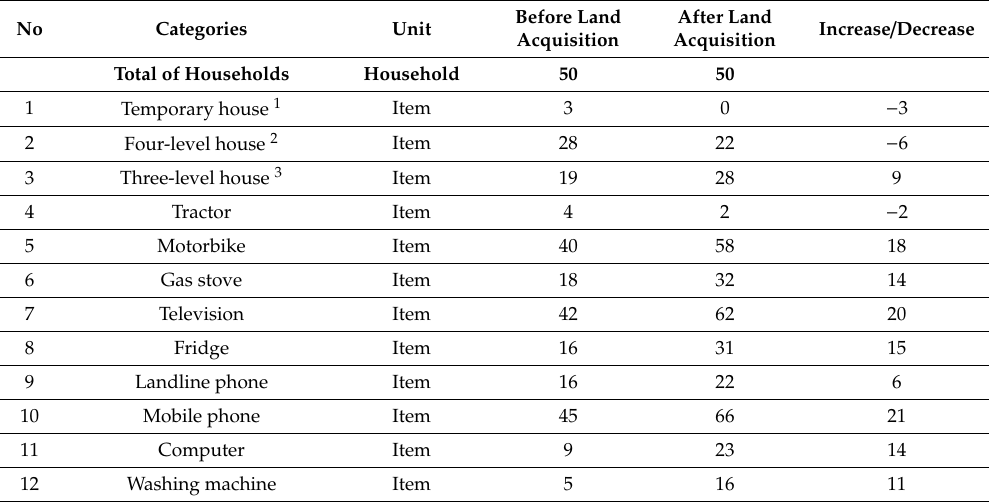
Table 5. Property owned by the surveyed